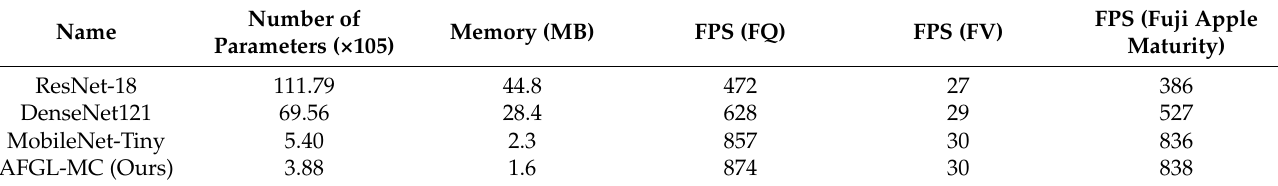
Table 5. Comparison performance in parameters, memory and